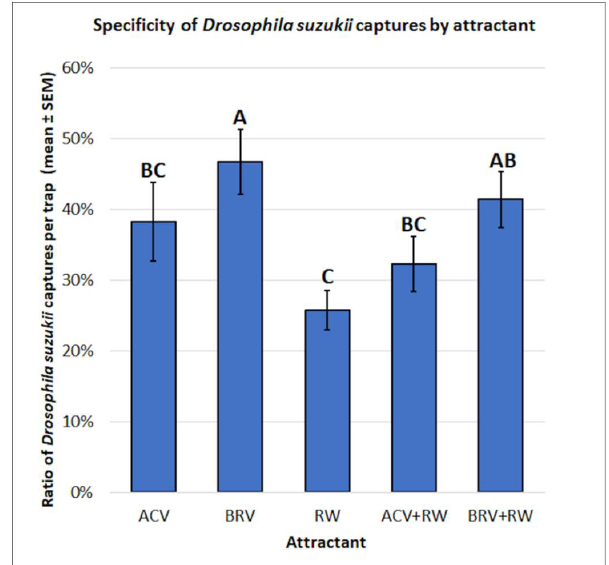
Figure 6. Specificity of Drosophila suzukii captures by attractant. Different letters represent statistically significant differences ( p < 0.05, Tukey’s HSD test) between attractant solutions.